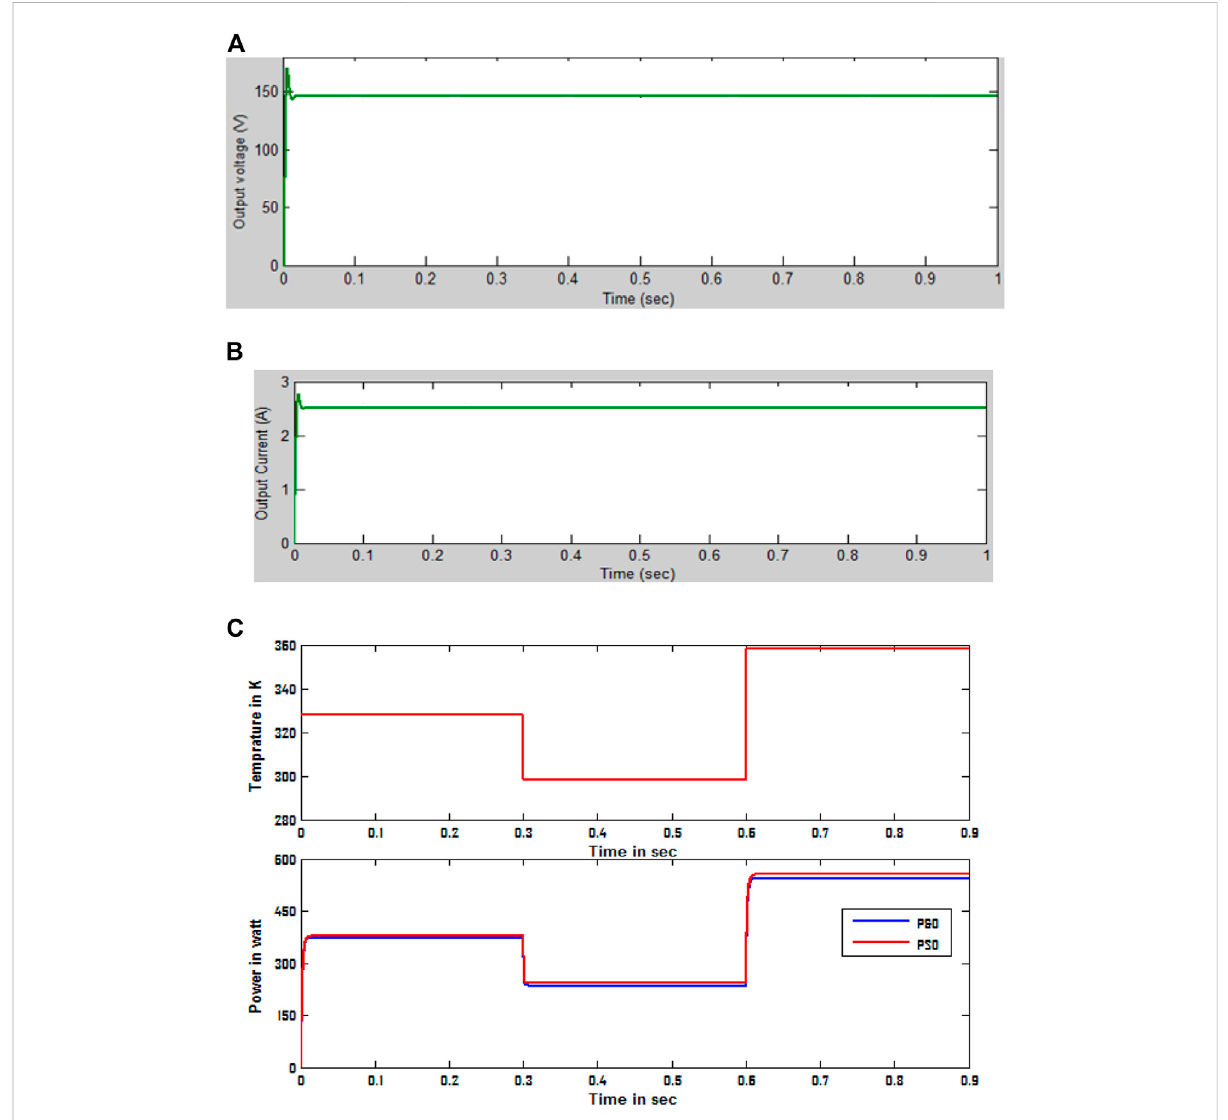
FIGURE 10 (A) The output voltage of the dual input single output non-isolated converter fed from a fuel cell (B) The output current of the dual input single output non-isolated converter fed from a fuel cell (C) The maximum power extracted from a PEM fuel cell using a PSO and a conventional P&O